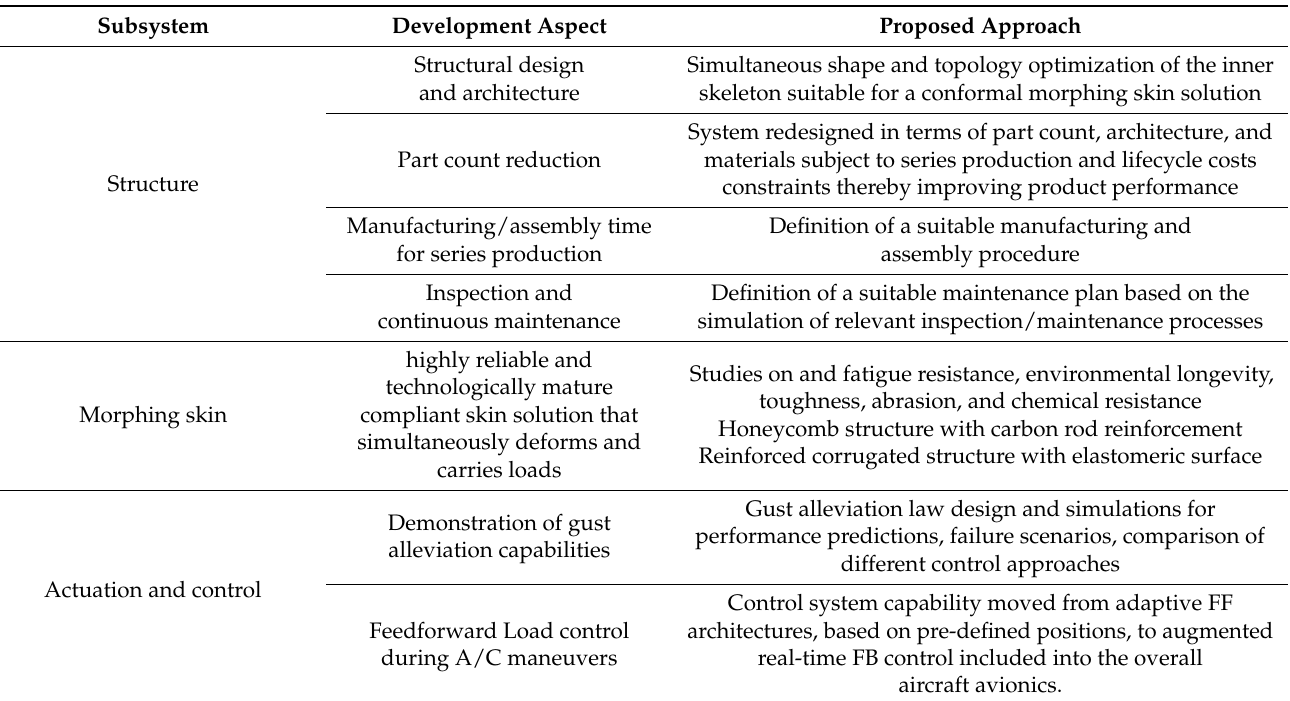
Table 3. Adaptive winglet, impacted development aspects, and proposed